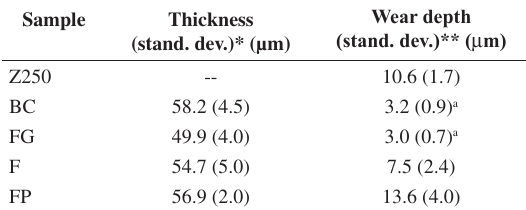
Table 2. Thicknesses of the sealants and wear depths of the scars formed on the surfaces of the composite resin and sealants. Mean value (standard deviation).